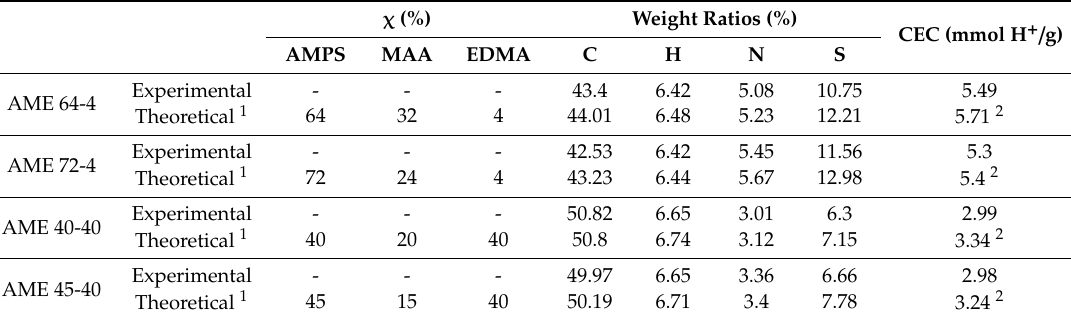
Table 2. The expected molar composition of the AME